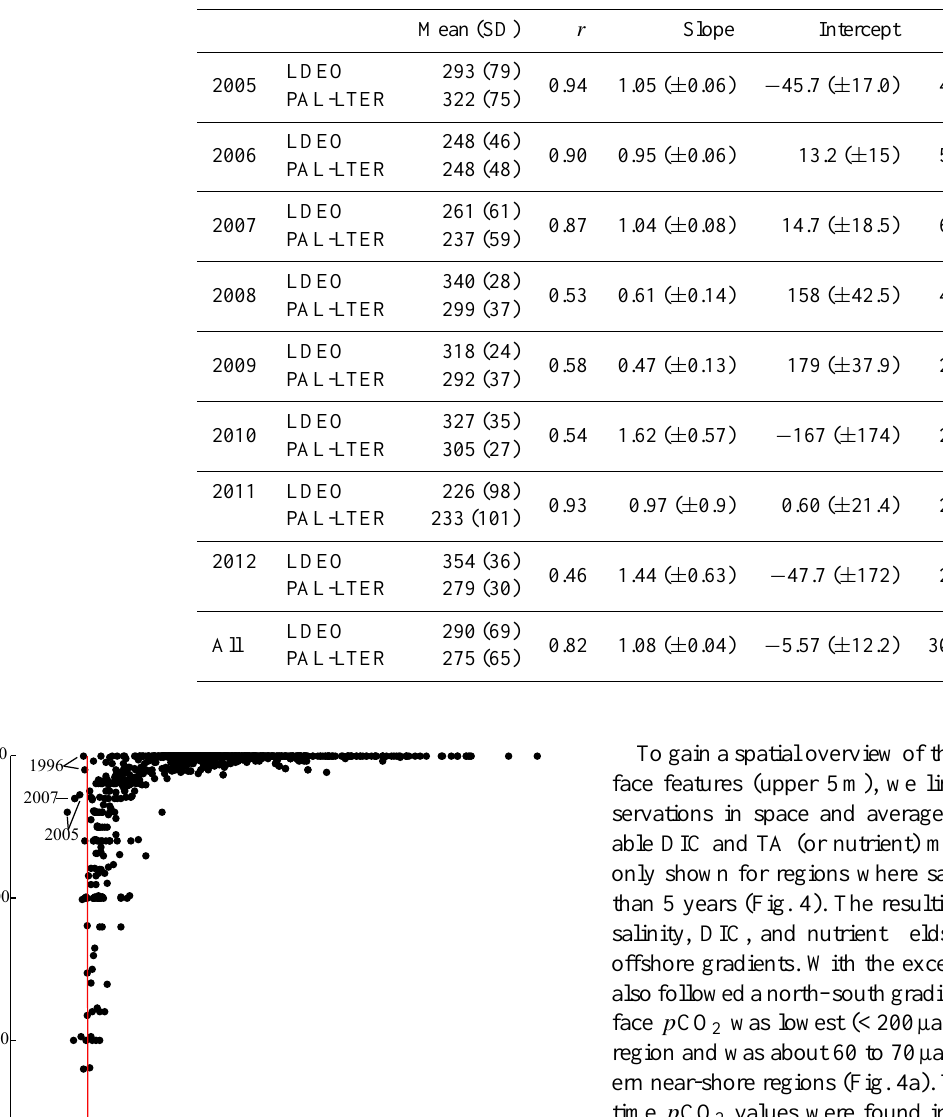
Table 1. Comparison of Lamont-Doherty Earth Observatory of Columbia University (LDEO) underway p CO 2 (µatm) data (Takahashi et al., 2015) with the p CO 2 (µatm) derived from PAL-LTER discrete surface samples over the Palmer-Long Term Ecological Research (PAL- LTER) sampling grid. The PAL-LTER discrete p CO 2 sample values were computed using the dissolved inorganic carbon (DIC, µmolkg − 1 ) and total alkalinity (TA, µmolkg − 1 ) . The analysis is based on the data after removing outliers as explained in the text.